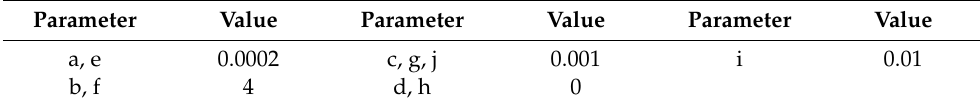
Table 2. Parameter settings in the SDS